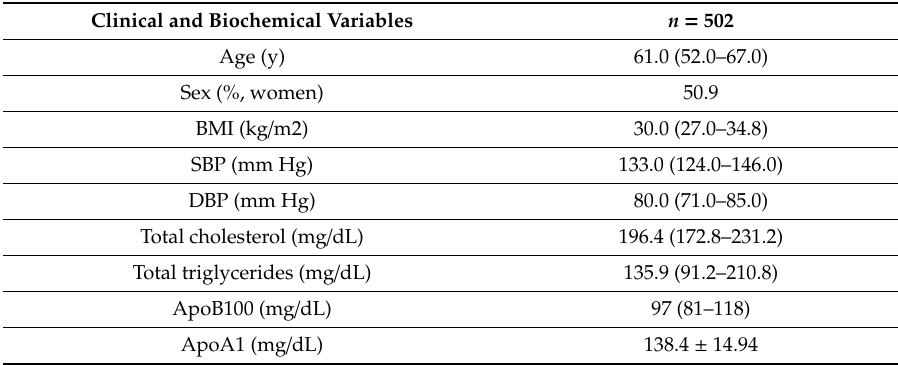
Table 1. Clinical covariates and lipids of the study